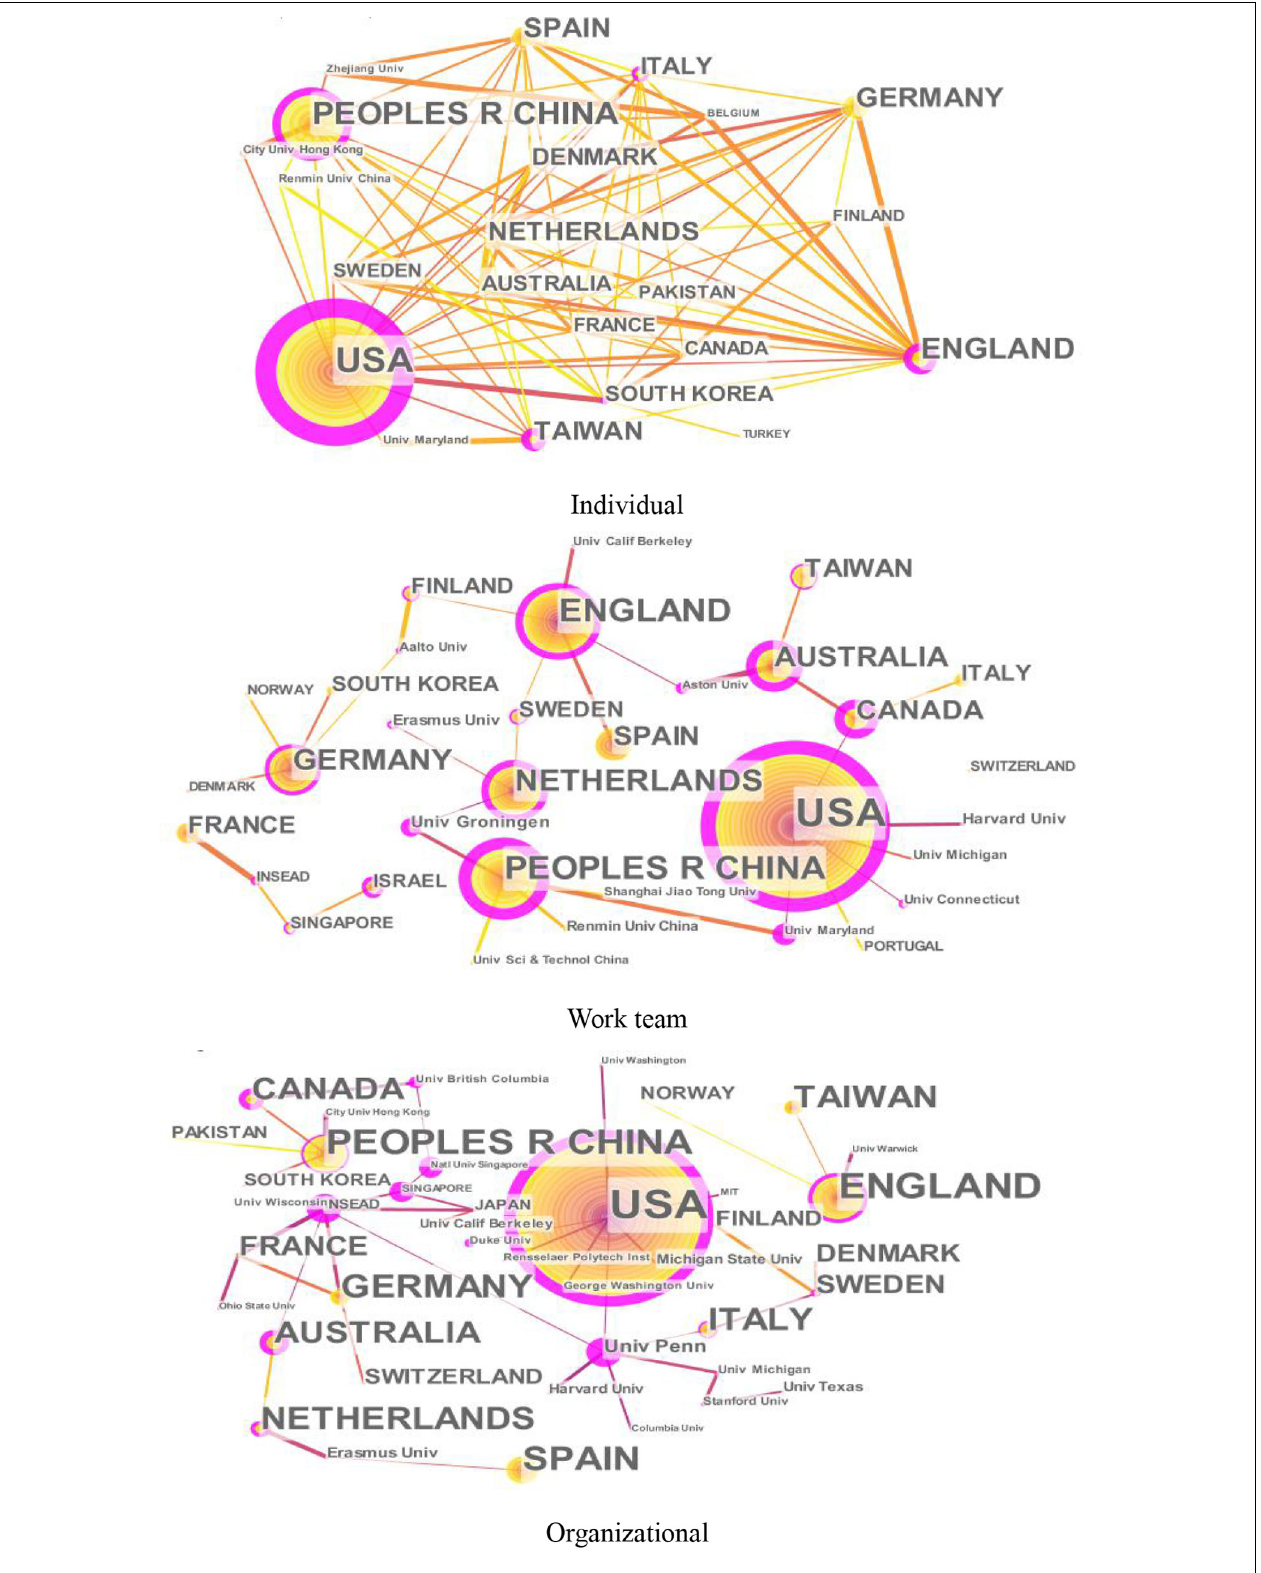
FIGURE 2 | Knowledge maps of countries (regions) of innovation research at different levels.